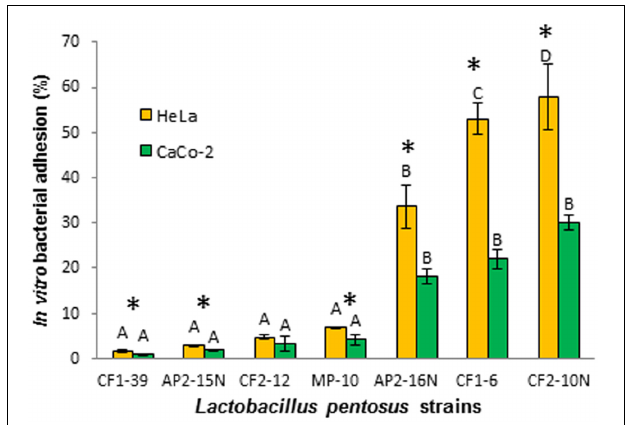
FIGURE 3 | Adhesion of Lactobacillus pentosus strains to Caco-2 (A) and HeLa 229 (B) cell lines. Different letters represent significant differences according to 2-sided Tukey’s test ( p < 0.05) measured between strains for each cellular line. Asterisks indicated significant differences according to 2-sided Tukey’s test ( p < 0.05) measured for each strain in both cellular